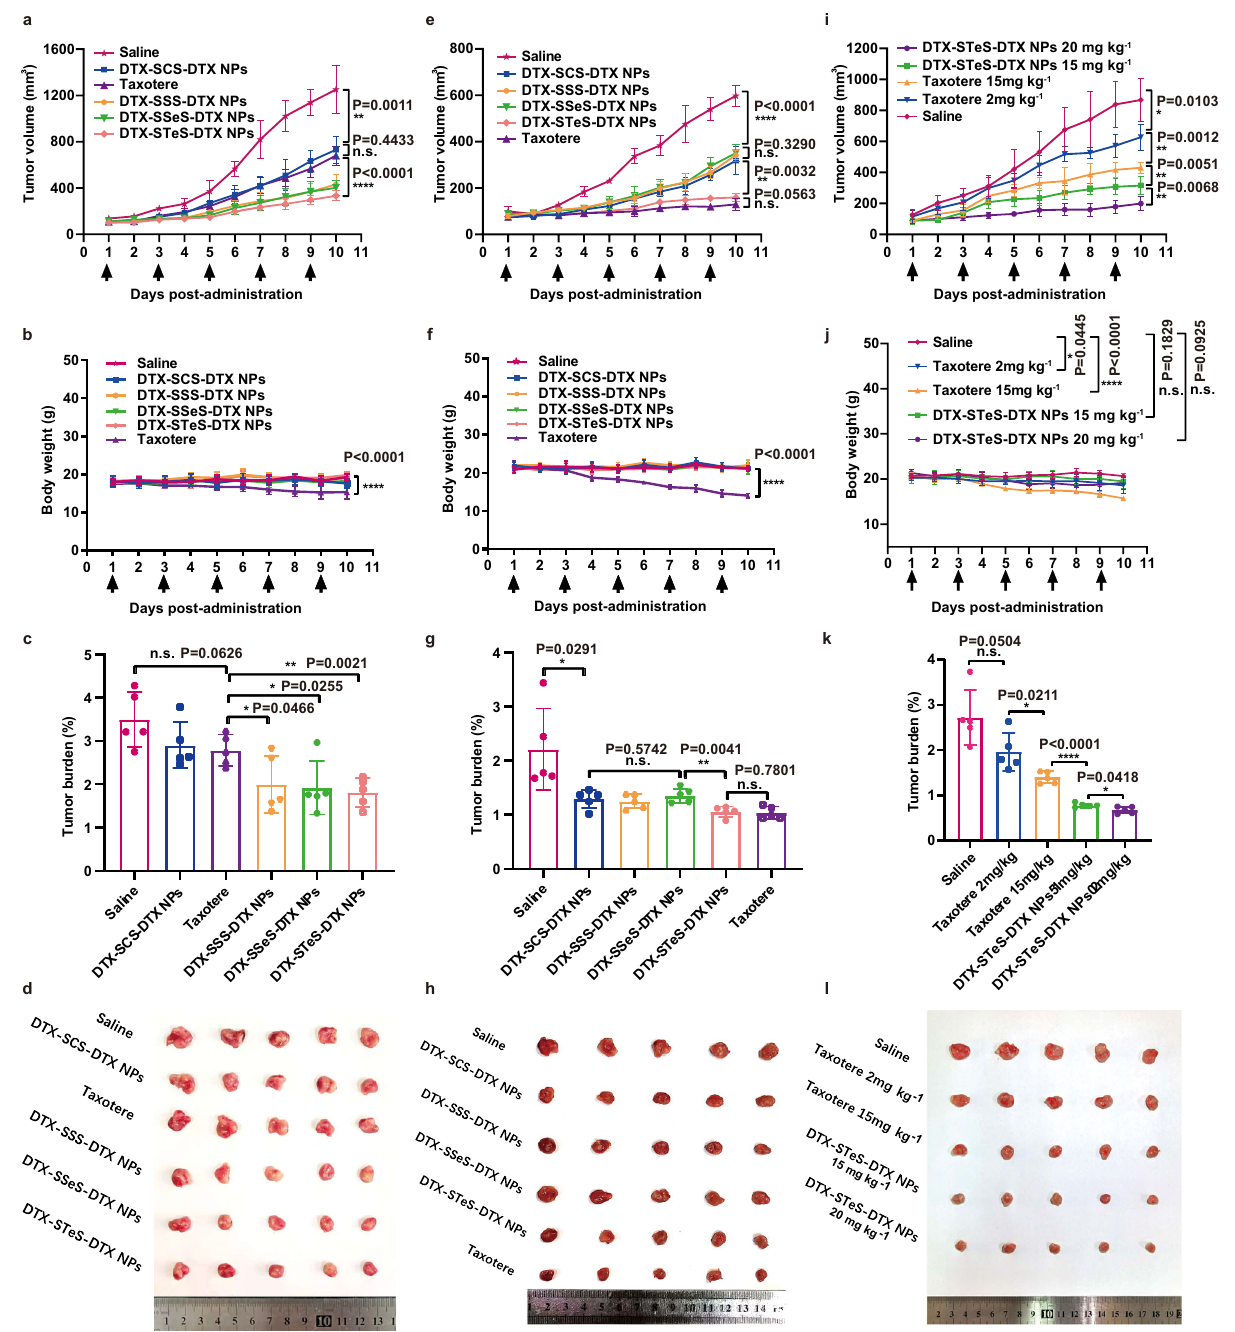
Fig. 7 | Antitumor ef fi cacy of HPNAs. Tumor growth pro fi les, body weight, tumor burden, and tumor photos: a – d low-dose (2mgkg − 1 ), e – h moderate- dose (10mgkg − 1 ), and i – l tolerated dose (15mgkg − 1 and 20mg kg − 1 ). All data